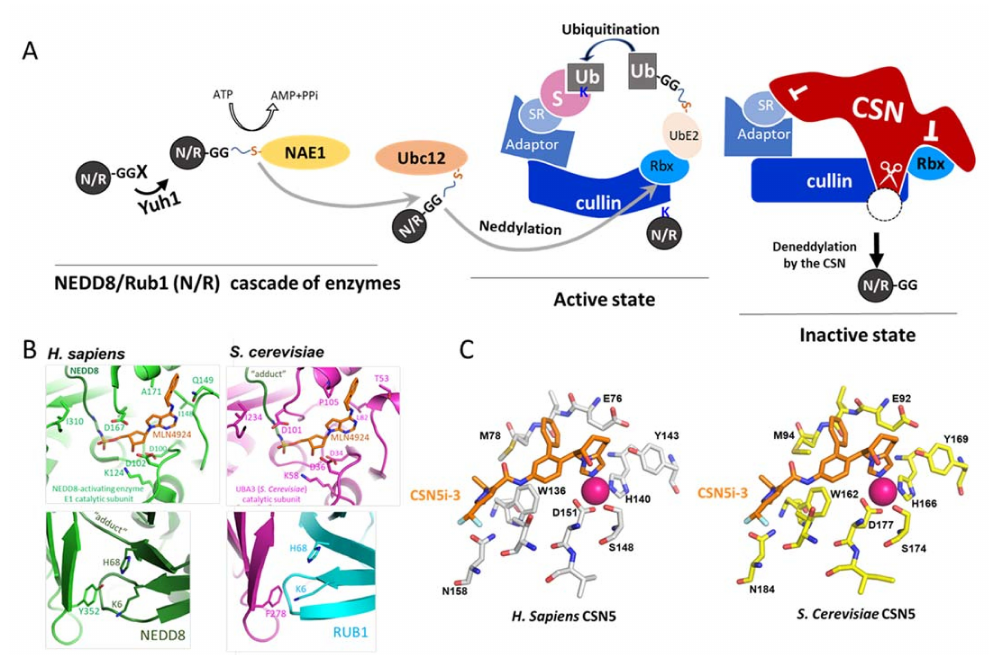
Figure 1. The evolutionarily conserved cullin neddylation/deneddylation enzymes. ( A ) A schematic model for cullin-RING ligase (CRL) activation and inhibition. NEDD8/Rub1 (N/R) is translated as a precursor that initially needs to be trimmed by the cysteine protease Yuh1 to expose the diglycine motif. Next, N/R is activated by ATP and forms thioester with an E1 (NAE1) enzyme. Following this step, N/R is trans-thiolized to an E2 (Ubc12) enzyme, which interacts with the RING subunit (Rbx) to transfer the N/R to a specific lysine (K) residue on a cullin. The N/R modification of cullins activate CRLs, which in return transfer ubiquitin (Ub) from Ub E2 (UbE2) enzyme to a substrate (S). Subsequently, CRLs are inhibited through N/R hydrolysis by the COP9 signalosome (CSN) complex, resulting in free N/R-GG. Notably, the CSN inhibits CRLs also non-enzymatically, through steric clashes ( ⊥ ). ( B ) Molecular model of the human (left, green) and Saccharomyces cerevisiae (right, magenta) NAE nucleotide binding sites with MLN4924 (top) or NEDD8/Rub1 (bottom). The S. Cerevisiae homology model was generated using SWISS-MODEL based on the structure of NAE1 in complex with NEDD8 and MLN4924 (PDB ID 3GZN), oriented as previously shown [25]. ( C ) Predicted active site of the S. cerevisiae Csn5 subunit, bound to the CSN5i-3 inhibitor. Active site of the human crystal structure of CSN5 in complex with the inhibitor CSN5i-3. Homology model was generated using SWISS-MODEL, using the PDB accession code 5JOG as a template, oriented as previously described [26]. Amino acids of the predicted active sites are shown in sticks and the zinc cations are shown in purple